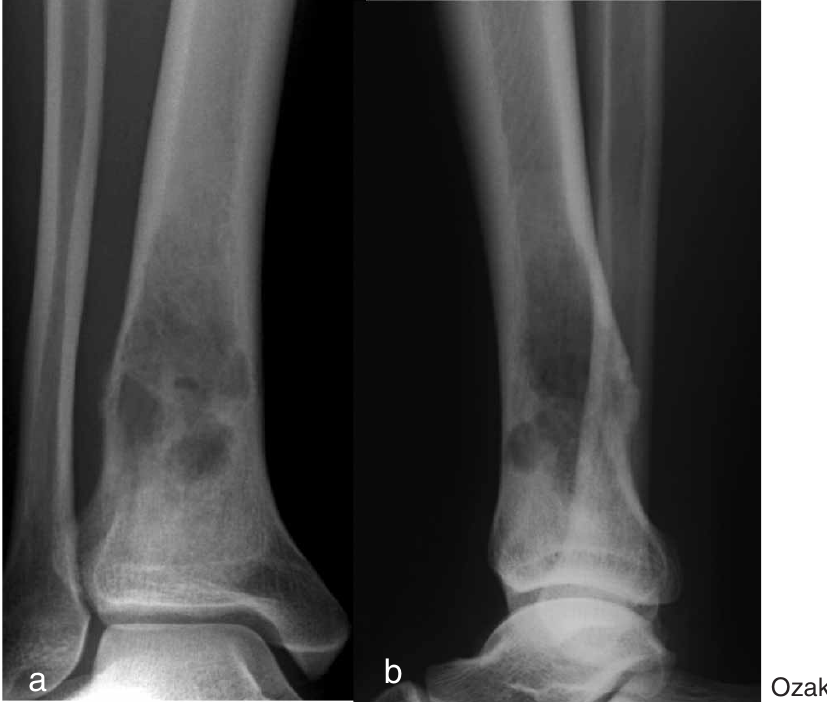
Fig. 1. Case 1 . Plain radiograph shows a radiolucent area with pathological fracture in the distal tibia. (a) Antero-posterior view; (b) lateral